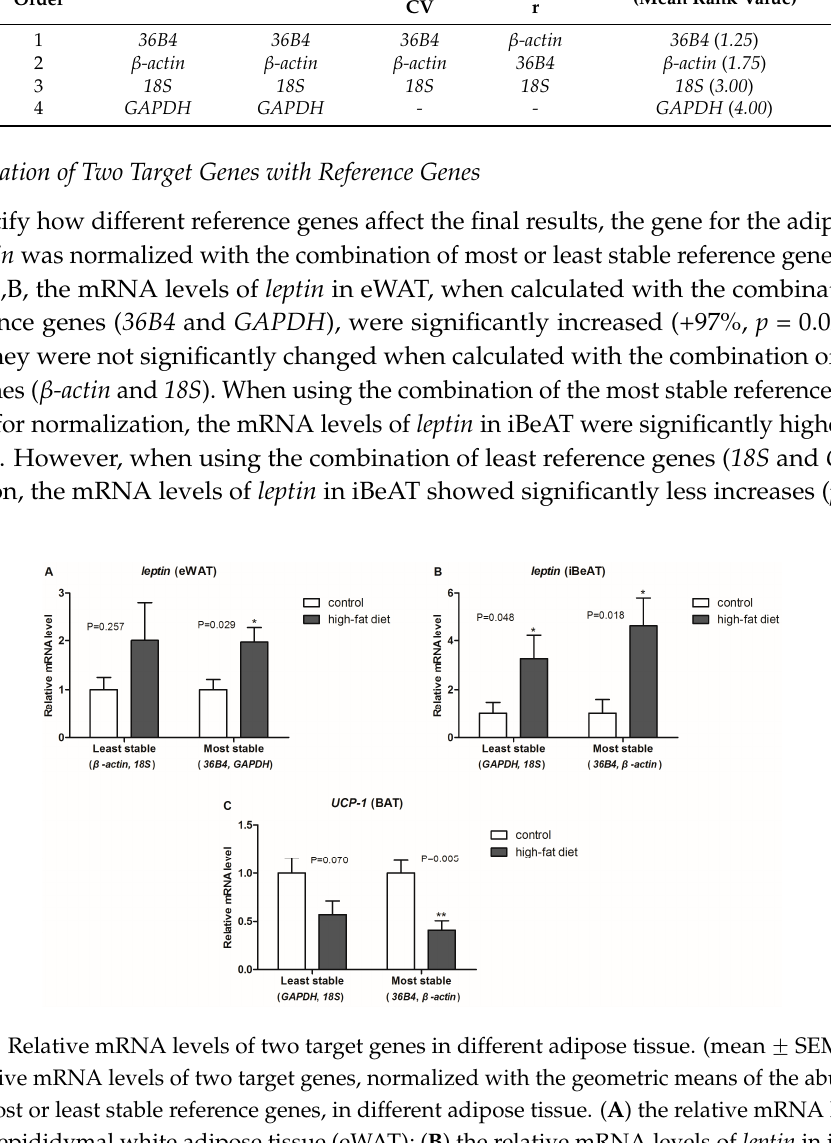
Table 6. Comprehensive ranking (BAT).